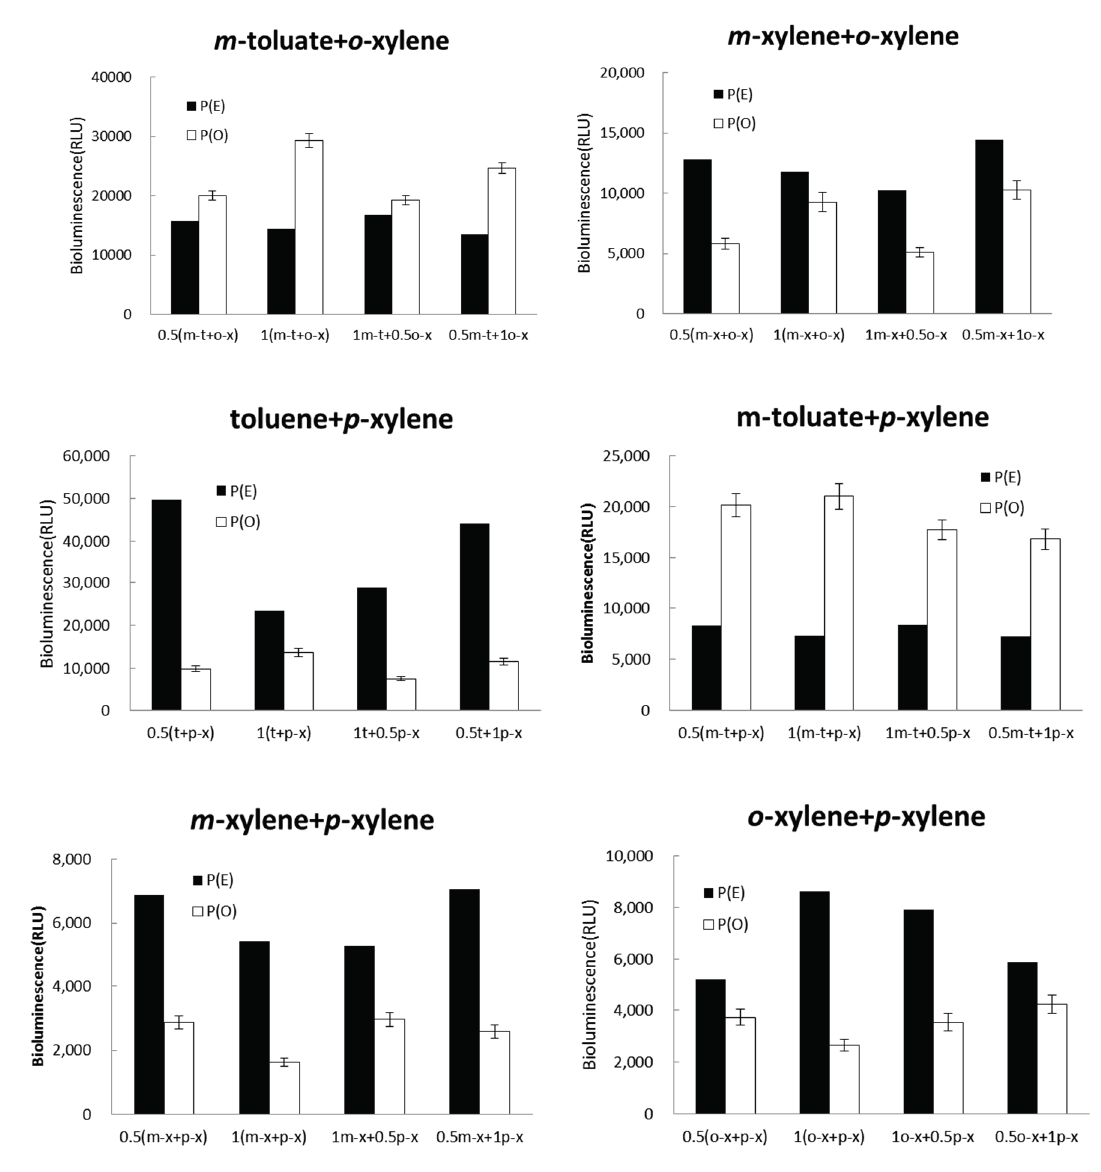
Figure A2. Comparison between P(O) and P(E) bioluminescence intensities in the presence of binary metal mixtures of 0.5 mM toluene. X -axis “num1 + num2” represents final concentration (mg/L) of each metal in the binary